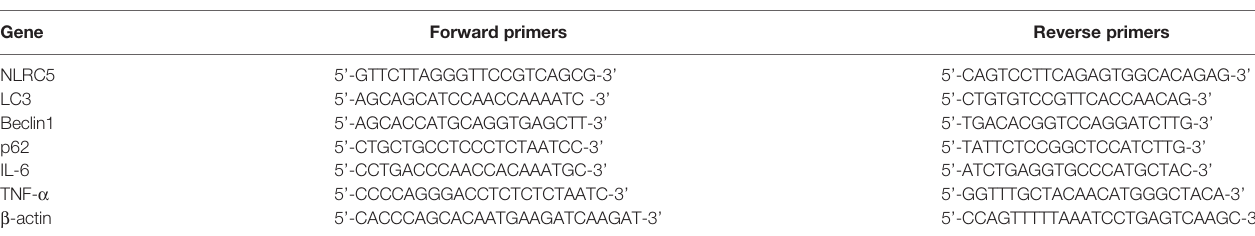
TABLE 1 | NLRC5, LC3, Beclin1, p62, IL-6, TNF- a , and b -actin primers for